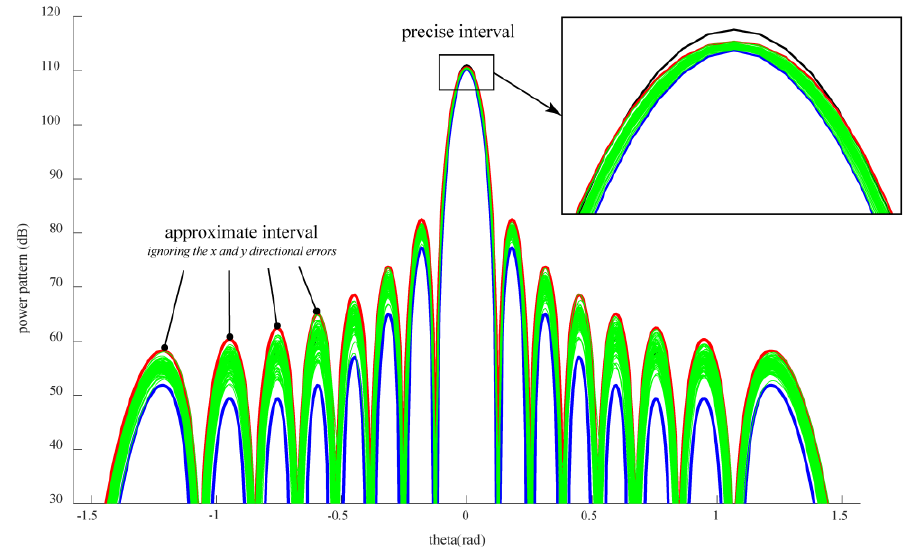
Figure 9. Monte Carlo simulation results of the whole array antenna. Each green line represents the realistic power pattern with the random hybrid errors. Only 100 sets of results are drawn in the figure for the clarity. Only the array factor was considered and the effect of the horn antenna was ignored.